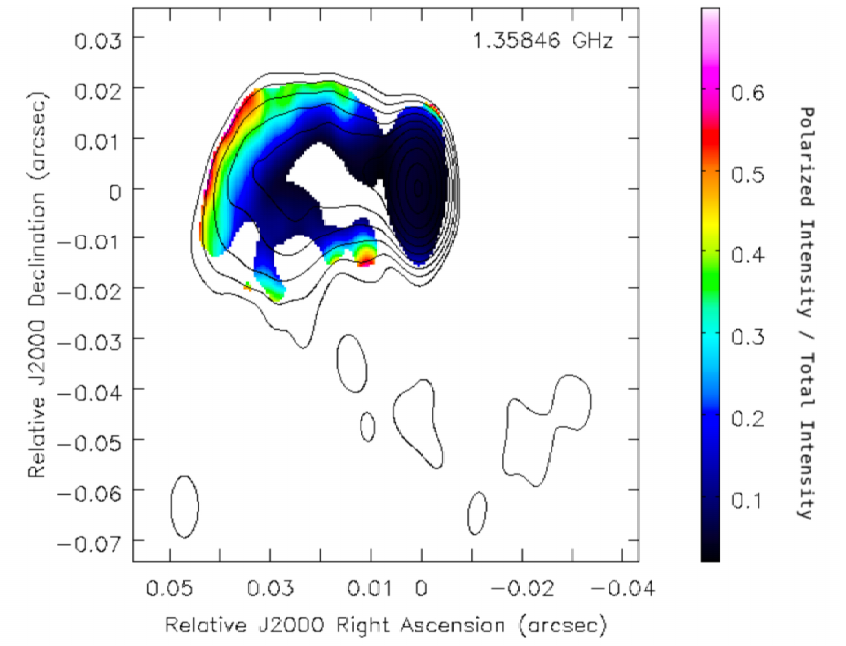
Figure 7. Possible curvature-induced polarization at the outer edge of a bend in the jet of J0738+1742. The EVPAs (not shown here) indicate a longitudinal B field along the outer edge of the curved jet and the fractional polarization rises toward the outer edge of the bend. The size of the Gaussian restoring beam is shown by the ellipse in the bottom left-hand corner of the image. The map is reproduced with permission from